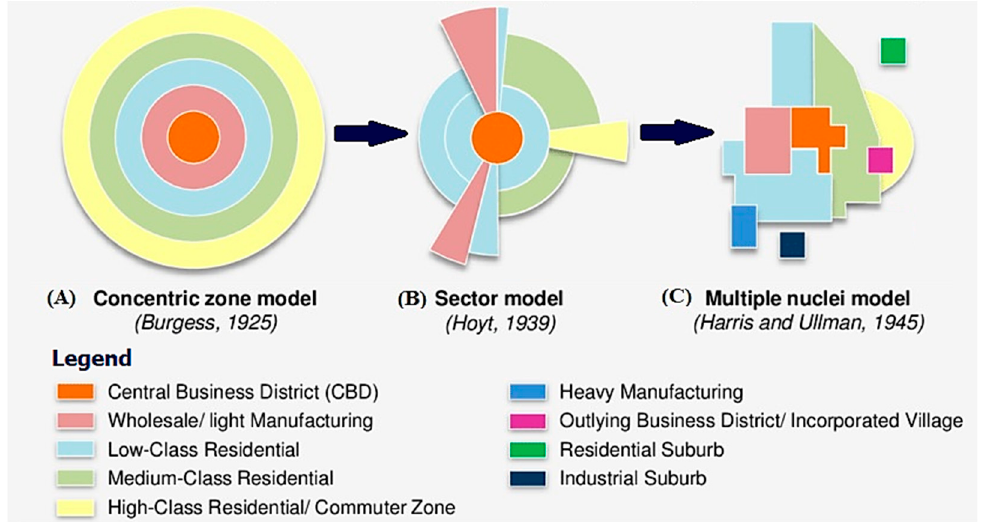
Figure 1. Classical models of urban structure: ( A ) Concentric zone model; ( B ) Sector model; and ( C ) Multiple nuclei model (Source: [12]).